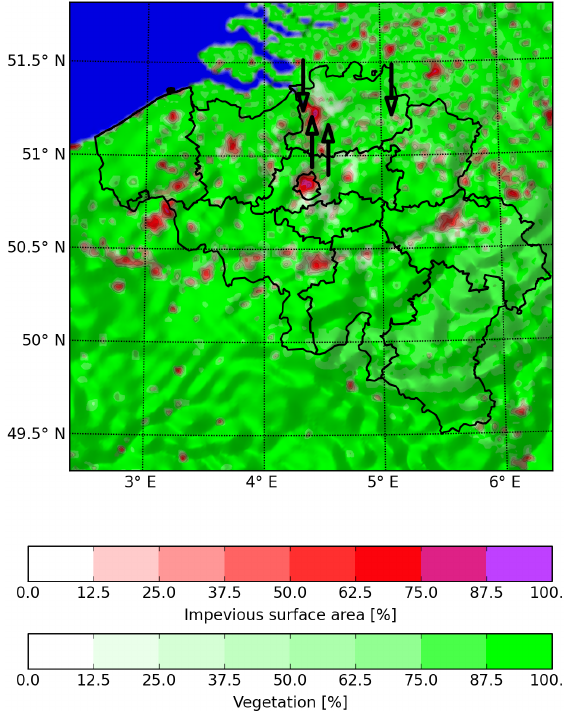
Figure 1. Domain composite of the impervious surface area, veg- etation cover and orography (indicated with the shading) for the reference (REF) model setup of the COSMO-CLM model coupled to TERRA_URB v2.0 at 2.8km resolution over Belgium. The ar- rows directed upwards indicate the locations of the in situ observa- tions located in the urban area of Antwerp (left; Royal Lyceum of Antwerp) and in the rural area of Vremde (right; Organic Farm van Leemputten). The arrows directed downwards indicate the locations of the tower observations located at a flat industrial terrain in Zwi- jndrecht (left arrow) of the Flemish Environmental Agency and at an rural area (right arrow) of the Belgian Nuclear Research Center (SCK • CEN) in